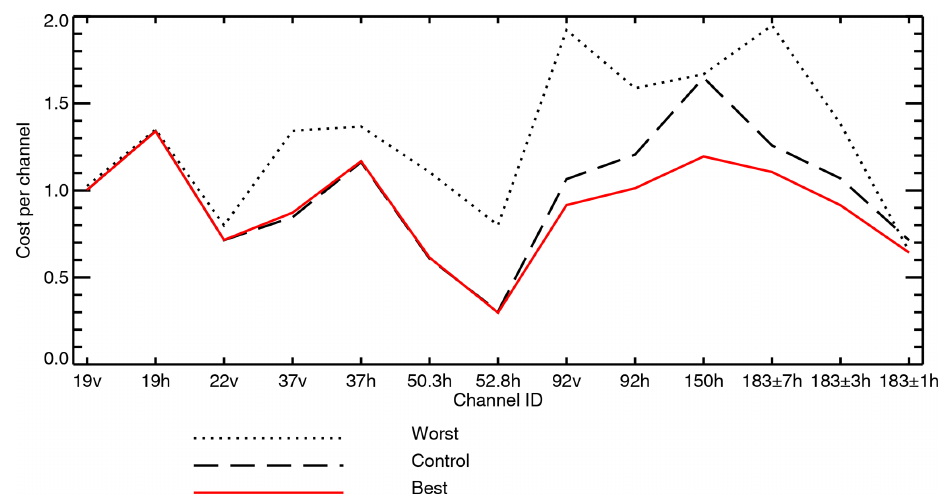
Figure 6. Cost per channel of different sets of physical options in the parameter estimation. Shown are the configurations with the smallest and highest cost (best and worst) and the control.